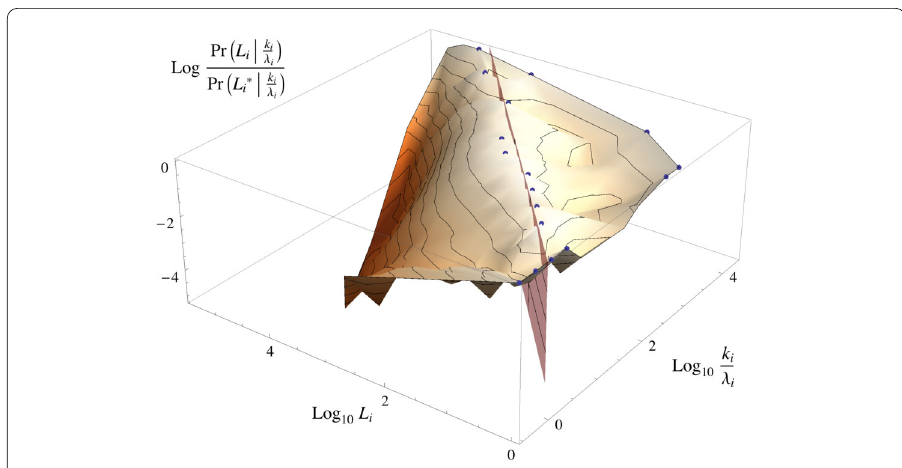
| k S ) with respect to log λ i for i / λ i )] (surface 10 L i and log 10 k i / i